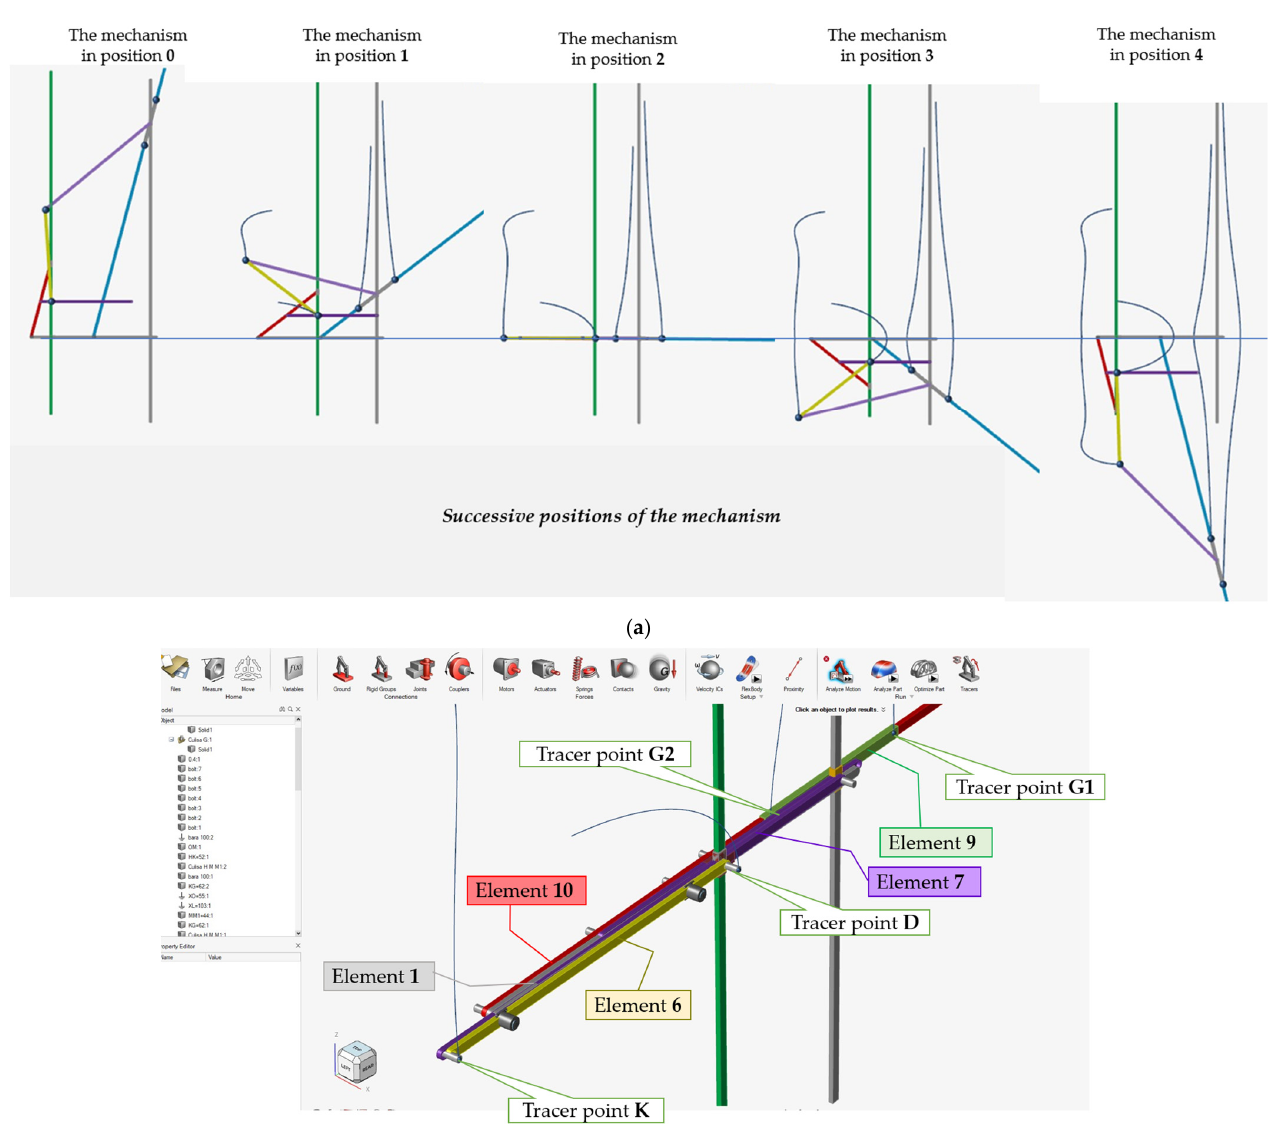
Figure 23. The mechanism during operation: ( a ) in five successive positions and ( b ) in one critical position (no. 2).